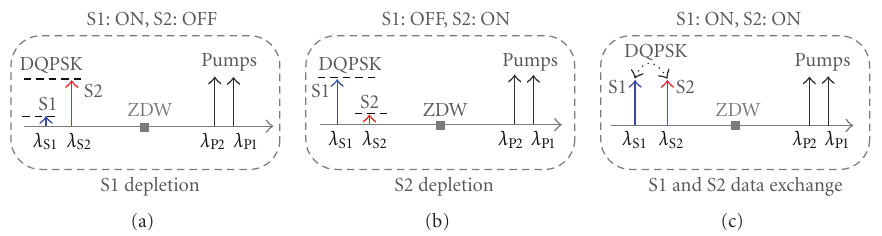
Figure 12: Concept and principle of nondegenerate FWM-based signal depletion and data exchange. (a) Signal 1 (S1) depletion. (b) Signal 2 (S2) depletion. (c) S1, S2 data